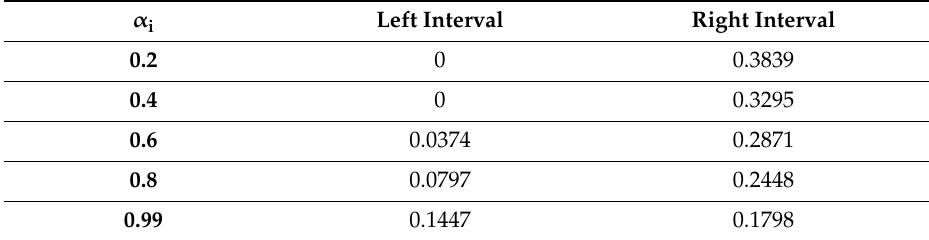
Table 6. Intervals generated by each alpha